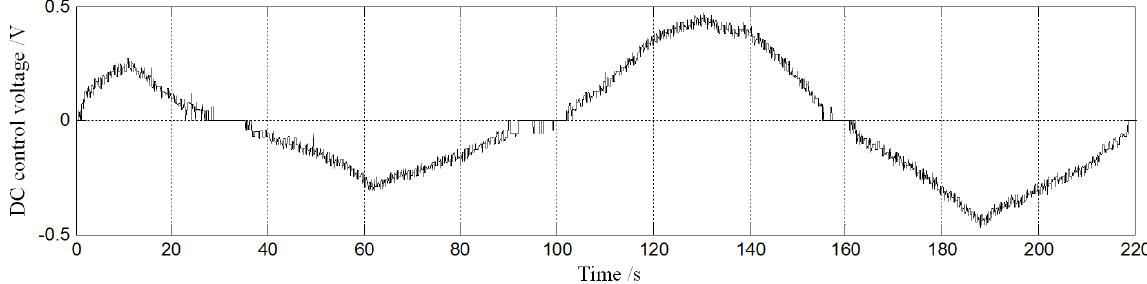
Figure 15. Control voltage of the proportional servo valve.